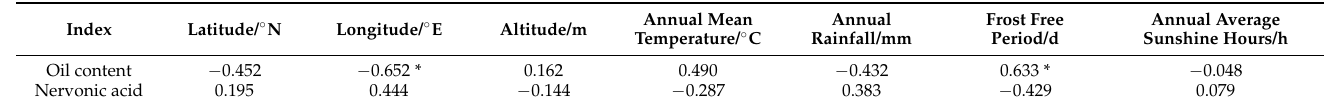
Table 6. Correlation between geographical and ecological factors and contents of kernel oil and nervonic acid in A. truncatum from different